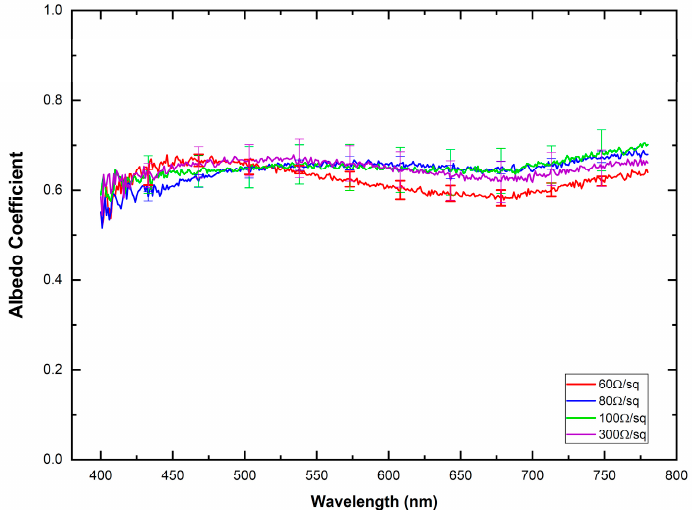
Figure 5. Spectral distribution of albedo coefficient for the different ITO-PET electrodes. Solid lines correspond to the mean value extracted from the measurements and their standard deviation is also indicated as vertical lines.